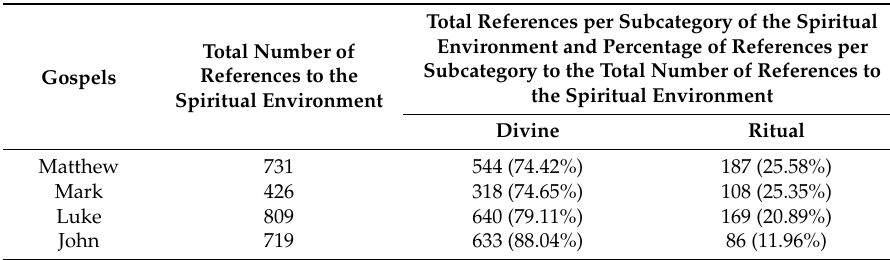
Table 11. Number of references to the spiritual